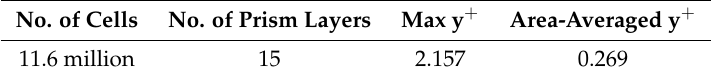
Table 4. Mesh details for CFD